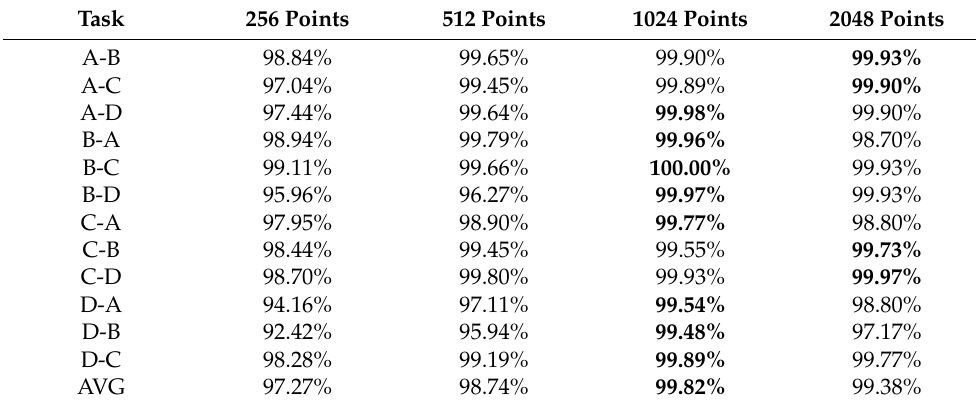
Table 4. Classification accuracies of different signal lengths. The numbers in bold indicate the highest classification accuracy in corresponding task.